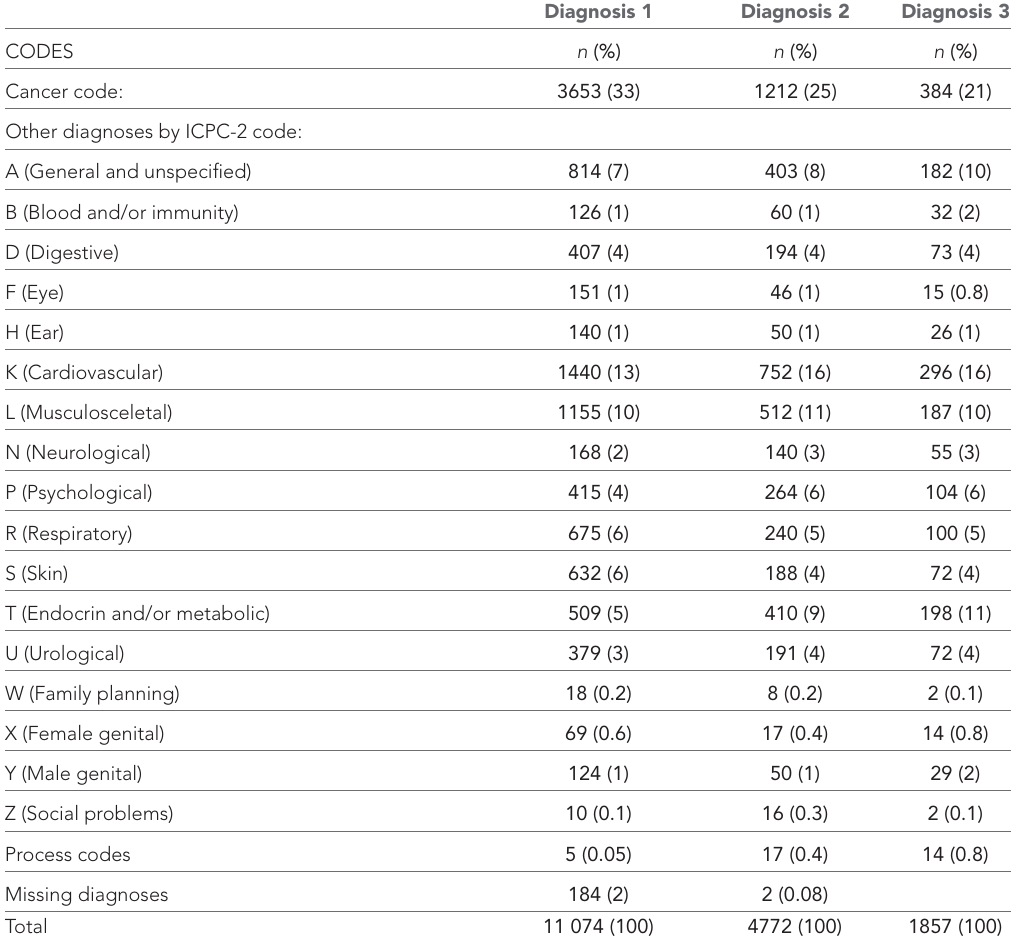
Table 4 Distribution of diagnoses by ICPC-2 groups in 11 074 GP consultations with 1932 patients with cancer during 1